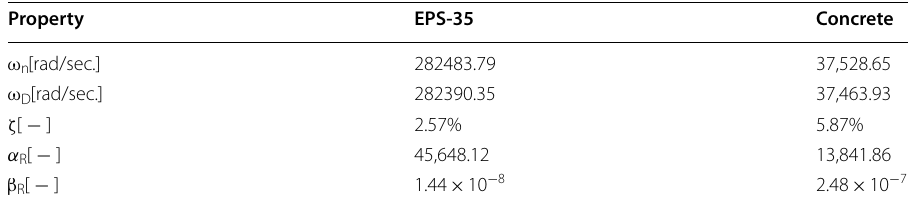
Table 1 Damping properties for EPS and concrete Property